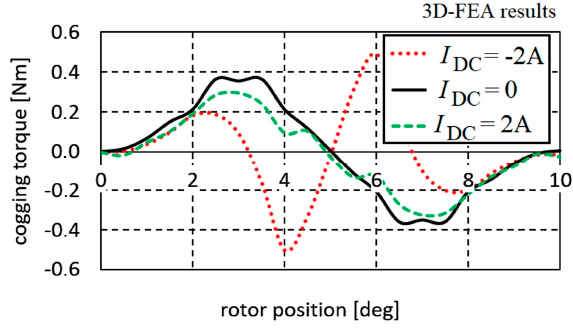
Figure 7. Cogging torque versus the rotor position at different DC field excitations for the UB1 rotor concept.